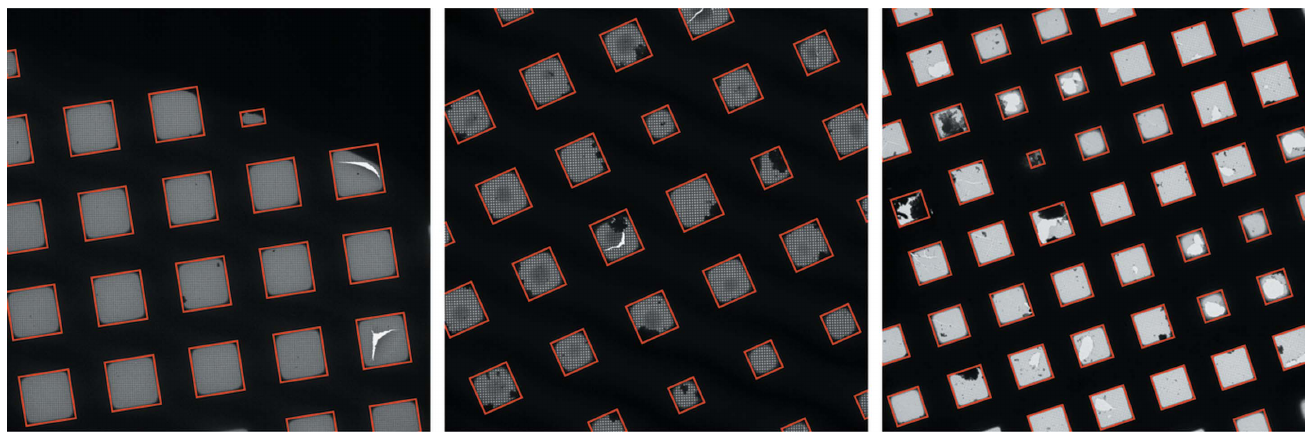
Figure 8 Example square localizations on low-magnification images. Ptolemy successfully segments bounding boxes around squares in the grid without human intervention.